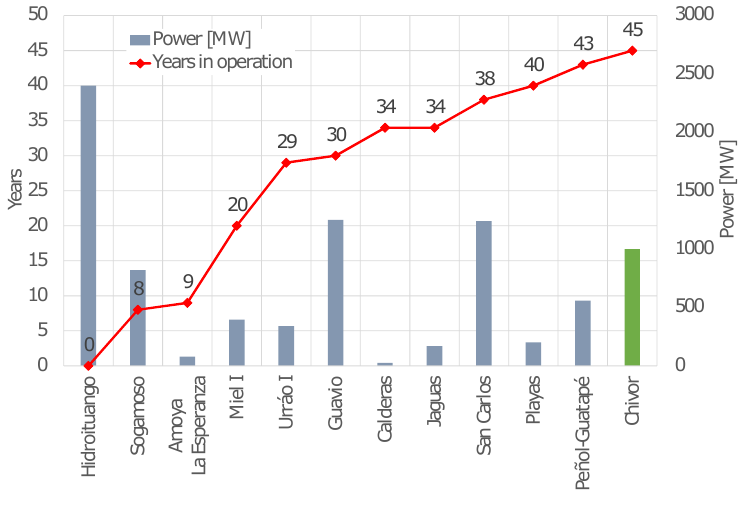
Figure 2. Age and installed capacity of Colombian hydropower plants